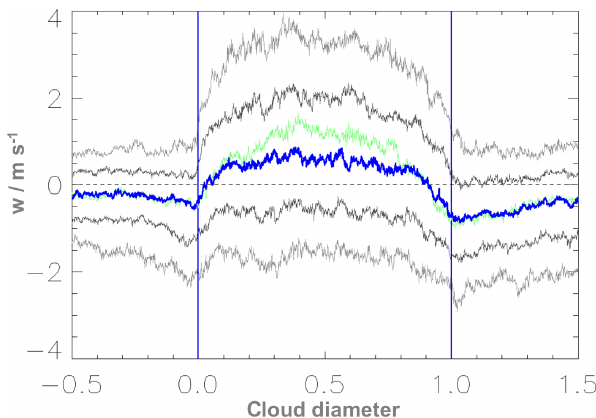
Figure 7. Distribution of the vertical wind speed of 191 cloud tran- sects: median (blue line) 10th, 25th, 75th and 90th percentiles (grey lines) with the scaling of the x axis and the cloud boundaries as in Fig. 6. The individual cloud transects are scaled by the cloud length. The transects are arranged in a way that the upwind side is on the left and the crosswind transects are shown from left to right. The vertical blue lines indicate the cloud boundaries. The solid green line is the median of the vertical wind velocity for 94 selected cloud transects, which fulfil the stricter cloud requirements in Table